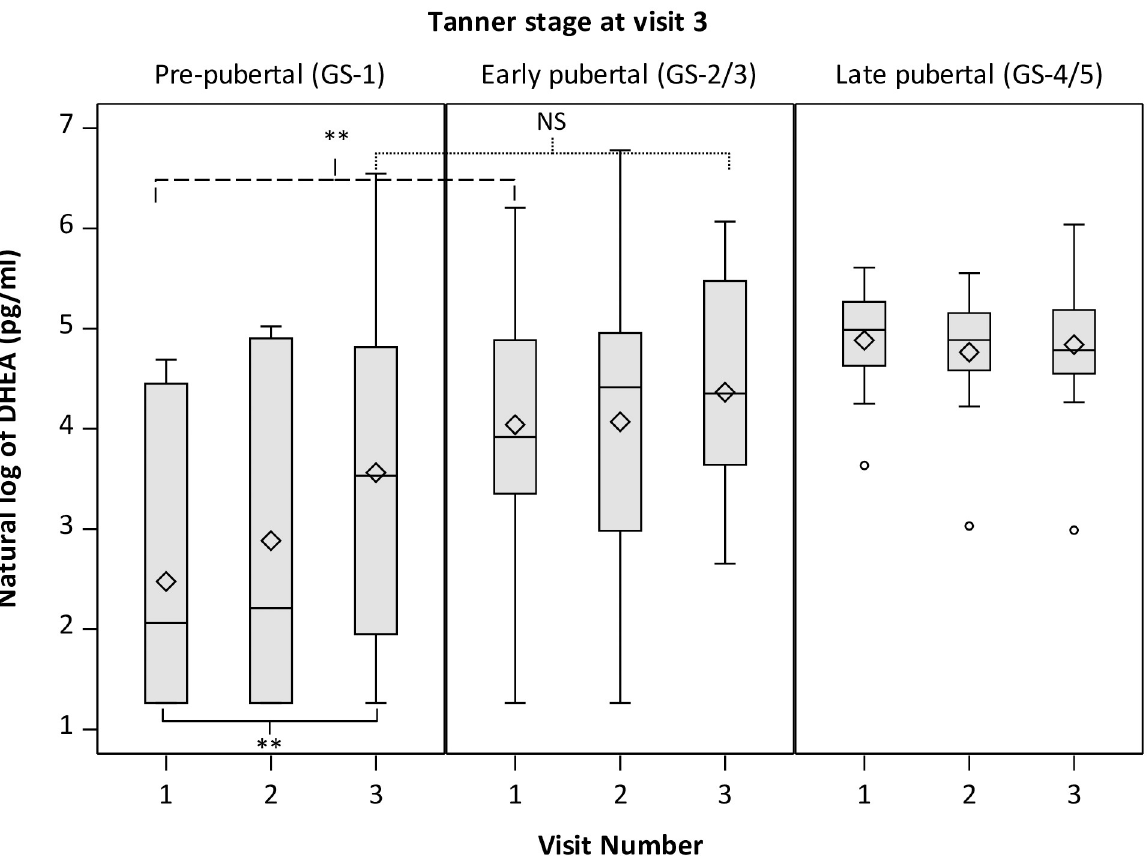
Fig 3. Salivary DHEA levels in boys by Tanner genital stage and visit. Boys are classified as pre-pubertal (GS-1), early pubertal (GS-2/3) or late pubertal (GS-4/5) based on self-report of Tanner genital stage at visit 3. P values from repeated measures analysis adjusted for BMI Z-score shown for V3 vs. V1 levels among GS-1 boys (solid), GS-2/3 vs. GS-1 at V1 (dashed) and GS-2/3 vs. GS-1 at V3 (dotted). NS = p � 0.05; � p < 0.05; �� p < 0.01.